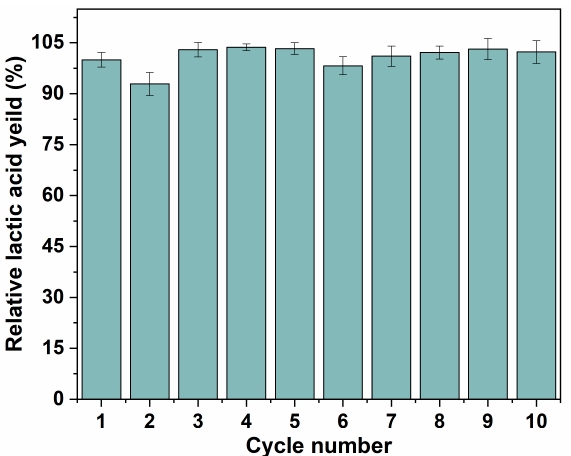
Figure 9. Recyclability and reusability of P. acidilactici immobilized PHI-1090 scaffold.